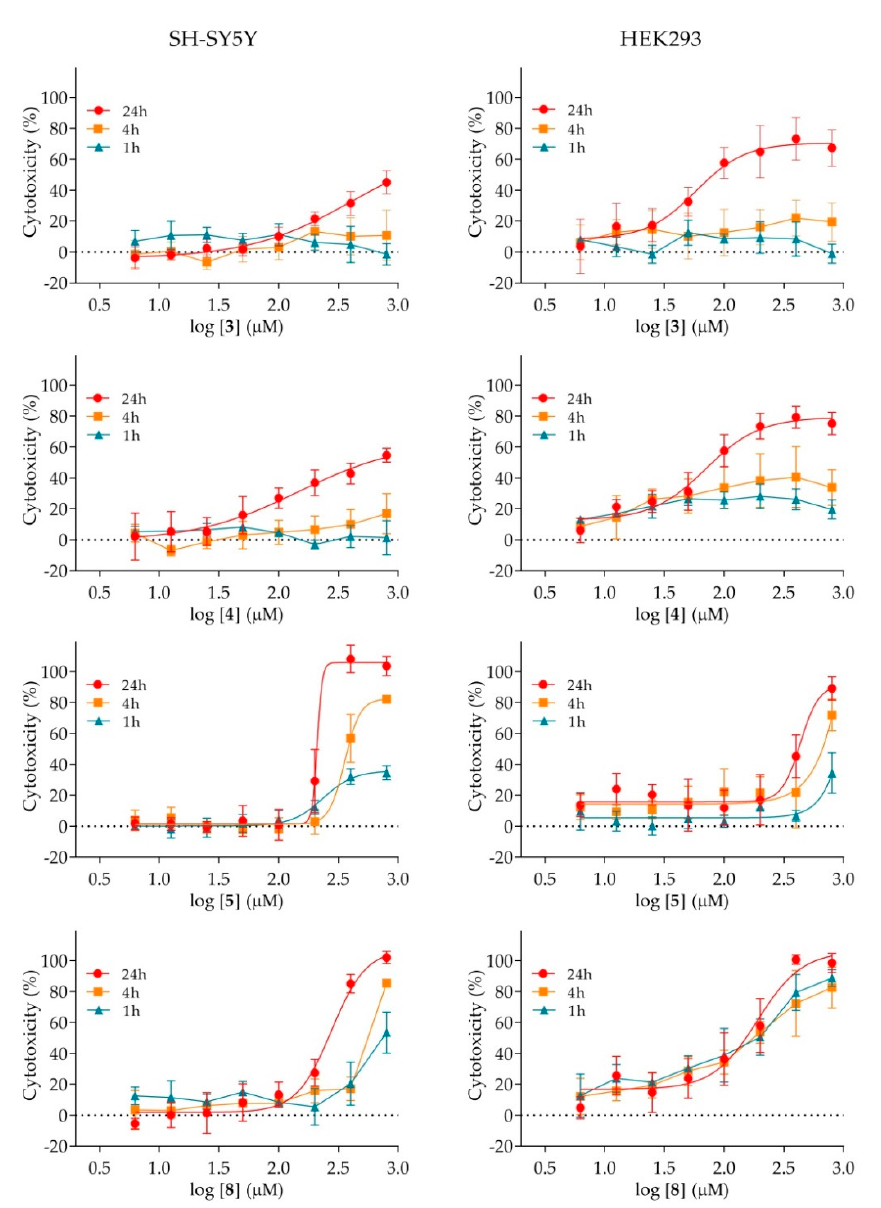
Figure 4. Time and dose-dependent cytotoxicity of selected nicotinamide derivatives on SH-SY5Y and HEK293 cells after 1-, 4- and 24-h treatment. Experimental data was presented as a mean of at least three experiments.